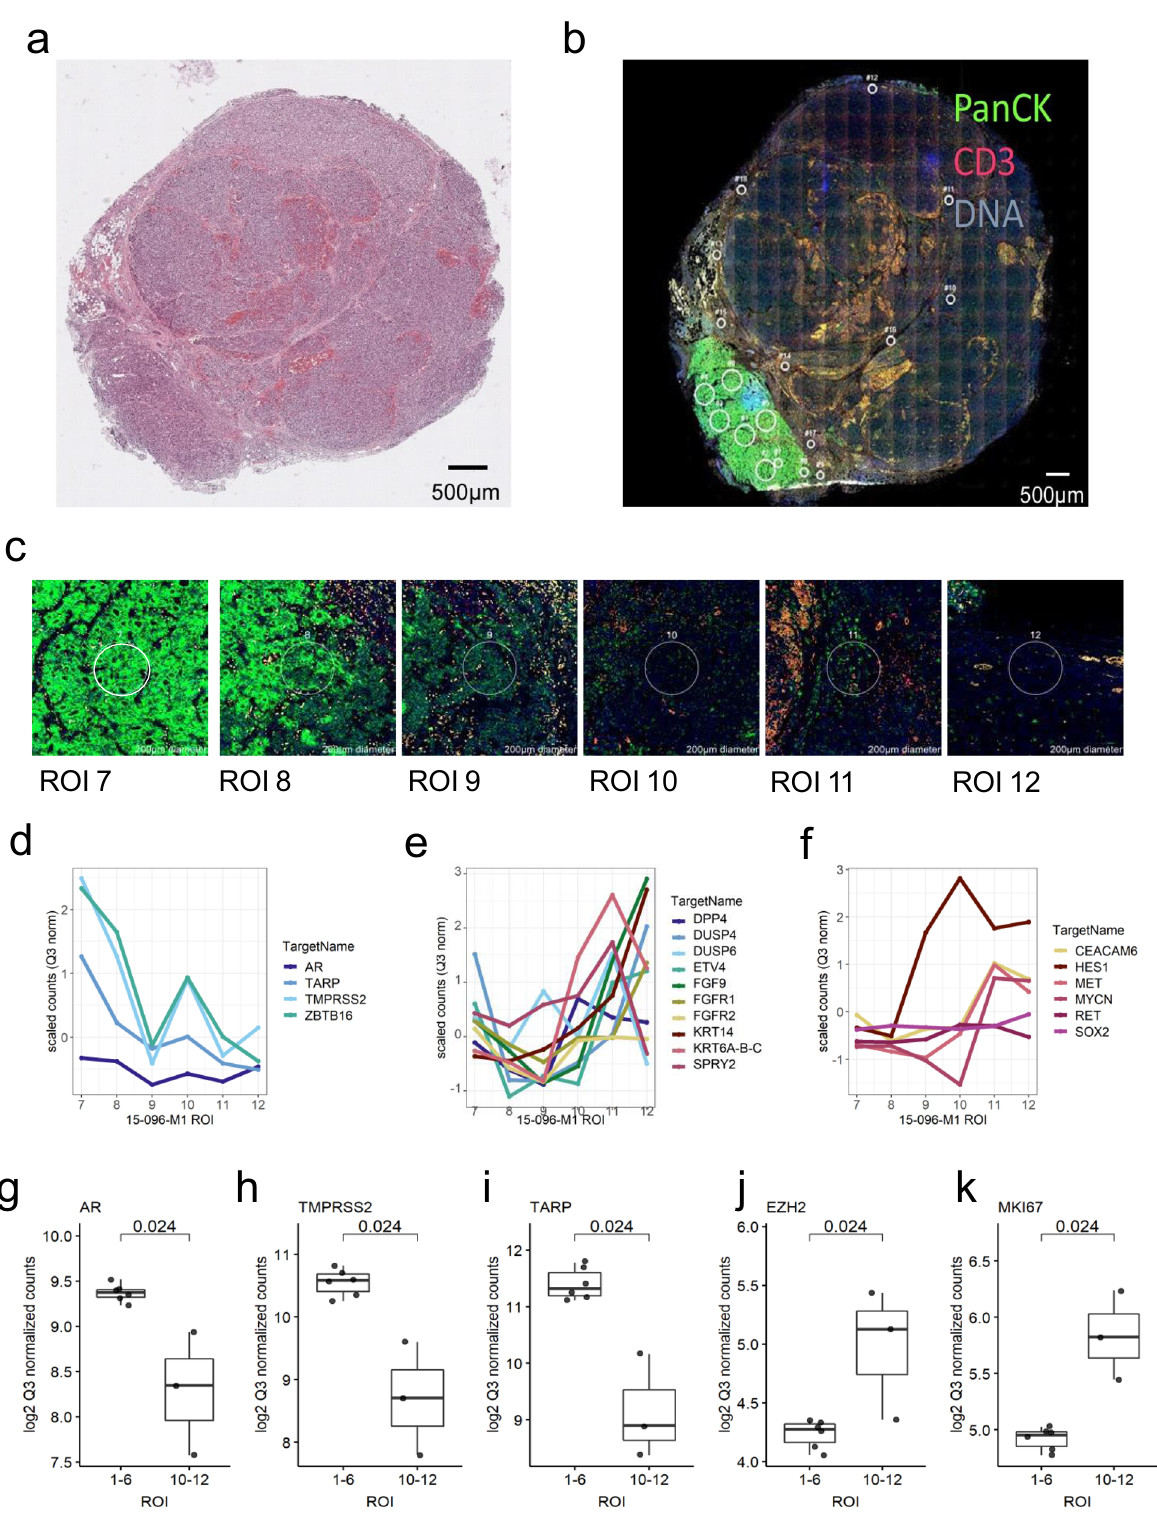
TMA construction . The study design comprised specimens from 27 patients with two metastatic sites included per patient: 52 soft tissues metastases (liver N = 17, lymph node N = 16, lung N = 6, other N = 13) and four bone metastases. Visceral metastases were identi fi ed at the gross level, bone biopsies were obtained according to a previously described template from 16 to 20 different sites 67 , and all metastases were veri fi ed at a histological level. Tissues were FFPE (bone metastases were decalci fi ed in 10% formic acid). TMAs were constructed from three 1-mm dia- meter cores punched from each FFPE tissue block for a total of 168 tumor cores arrayed across three recipient TMA